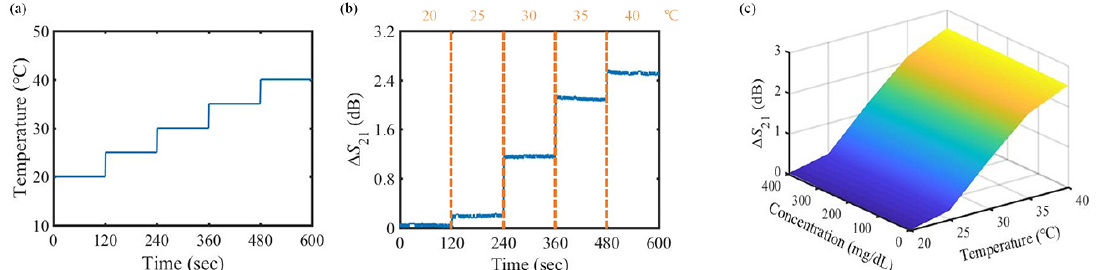
Figure 7. Relationship between the temperature and the transmission coefficient of the proposed sensor. ( a ) variation in temperature increases by 5 ◦ C from 20 ◦ C to 40 ◦ C every 2 min; ( b ) variation in transmission coefficient under varying temperature condition when the DI water flows through the fluidic channel; and ( c ) variation in transmission coefficient for the other concentrations of the glucose solution under varying temperature condition.